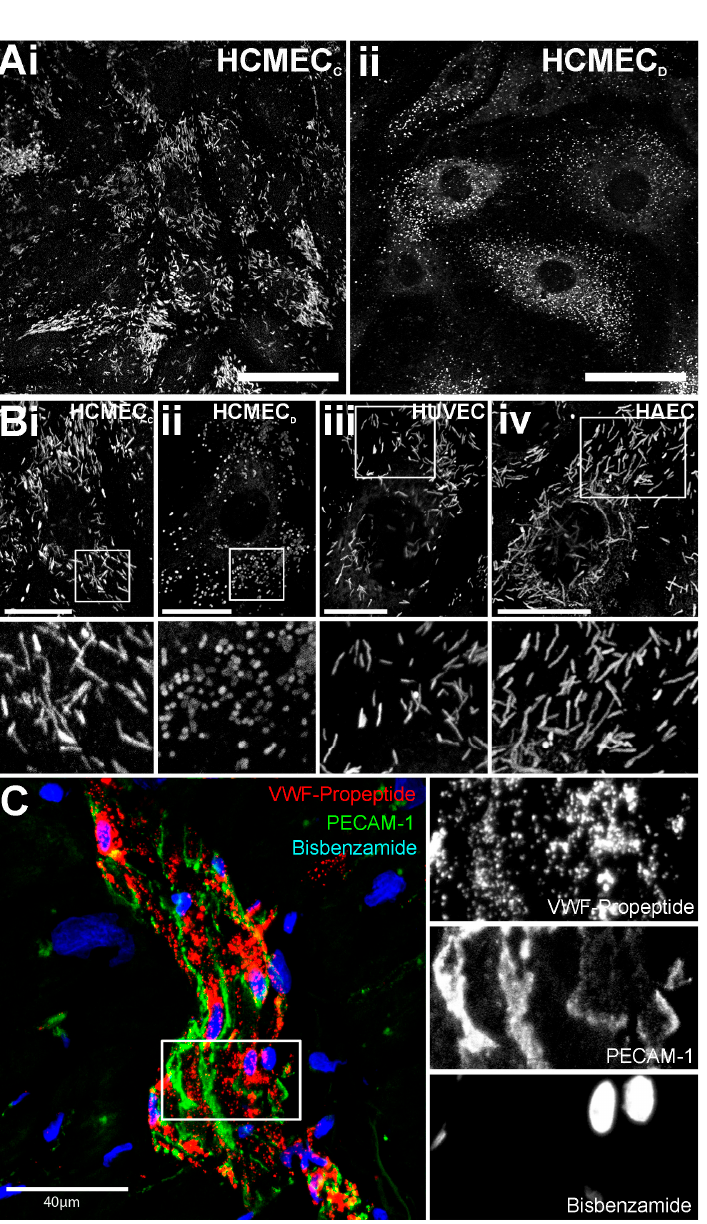
Figure 1. HCMEC D in culture and in situ contain WPBs with a rounded morphology. Top panels in ( Ai,ii ) show representative confocal fluorescence images of ( i ) cultured HCMEC C and ( ii ) HCMEC D immune-labelled for endogenous VWF. Top panels in ( Bi – iv ) show higher magnification of WPB morphology in individual ( i ) HCMEC C , ( ii ) HCMEC D , HUVEC ( iii ) and HAEC ( iv ). Scale bars: 10 µm. The regions indicated by the white boxes in ( B ) are shown on an expanded scale in the lower panels. Images from HCMEC C are representative of n = 3 separate donors, for HCMEC D , n = 6 donors. Images acquired using a Leica SP2 confocal microscope and Leica confocal software TCS SP2 Version 2.5(Mannheim, Germany) equipped with 63× 1.4NA HC PL APO oil immersion objective. ( C ) shows a representative image of a 100 µm thick section of cardiac ventricle immune-labelled for endogenous VWFpp (red), PECAM-1 (green) and the nuclear stain Bisbenzamide (blue). The region indicated by the white box in ( C ) is shown on an expanded scale on the right. VWF; von Willebrand factor. HCMEC; human cardiac microvascular endothelial cells ( C ; control, D ; dilated cardiomyopathy). HUVEC; human umbilical vein endothelial cells. HAEC; human aortic endothelial cells. VWFpp; von Willebrand factor propeptide. PECAM-1; platelet endothelial adhesion molecule-1. WPBs; Weibel–Palade bodies.